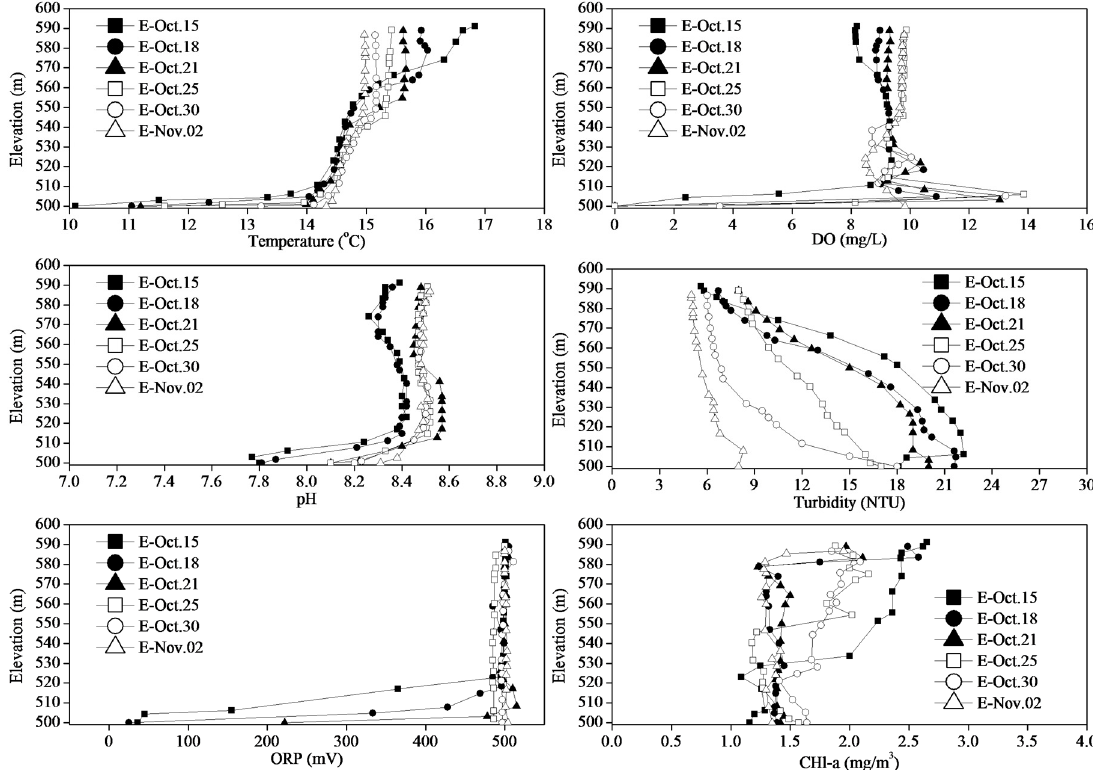
Figure 1. Variation of T, DO, pH, turbidity, ORP, and CHl-a in the enhanced area during the operation of WLAs (E—indicates “enhanced area”).